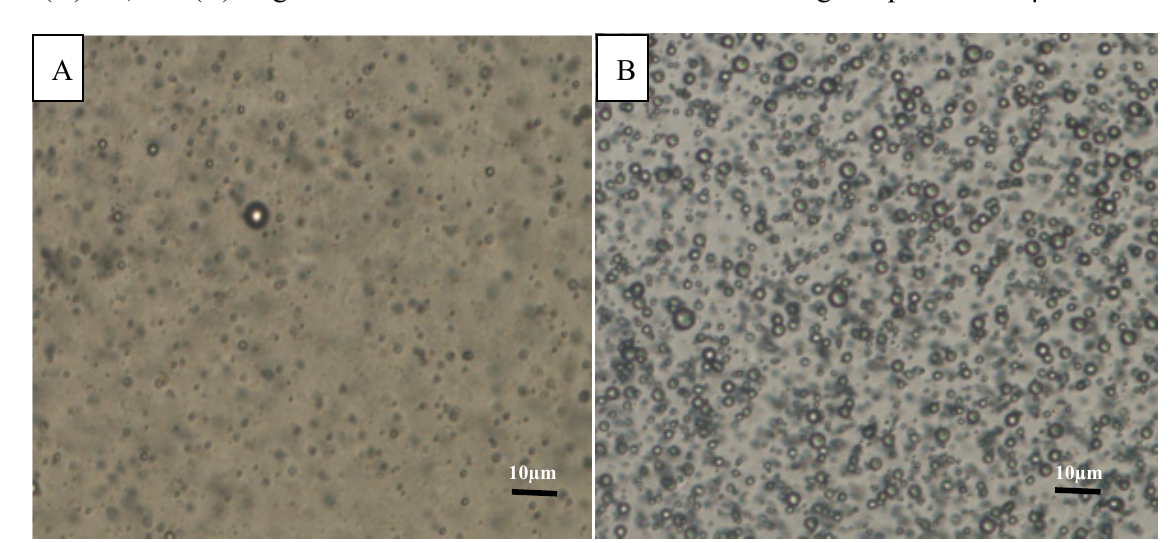
Figure 1. Microscopic observation of commercial emulsion samples ( A ) C1, ( B ) C2, ( C ) C3, ( D ) C4, and ( E ) virgin coconut oil emulsion. Scale bar in all images represents 10